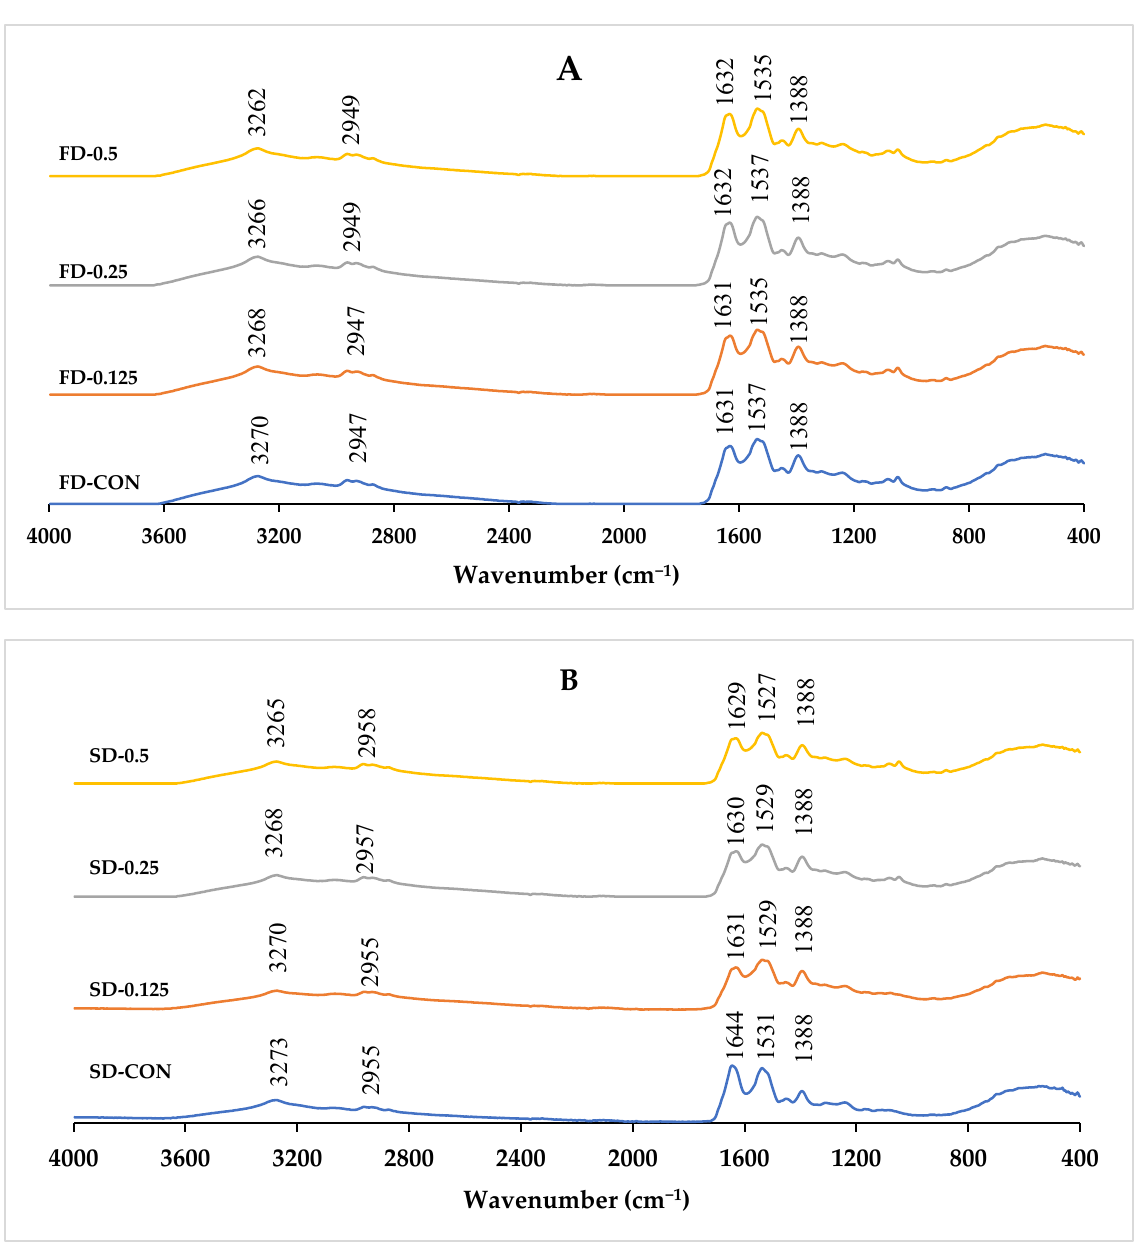
Figure 2. FTIR of ( A ): freeze-dried (FD), and ( B ): spray-dried (SD) fish myofibrillar proteins (FMP) modified with tannic acid (TA) at varying concentrations. CON: No TA added. Numbers represent the level of tannic acid (%) used for modification.